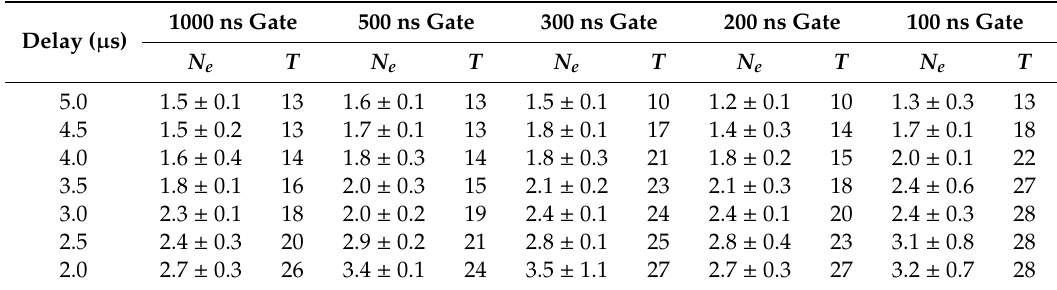
Table 3. Electron densities and temperatures deduced from experimental values of Stark broadening of the H α -line obtained in the LSP experiments of this work. N e is 10 17 cm − 3 units and T is 10 3 K units.